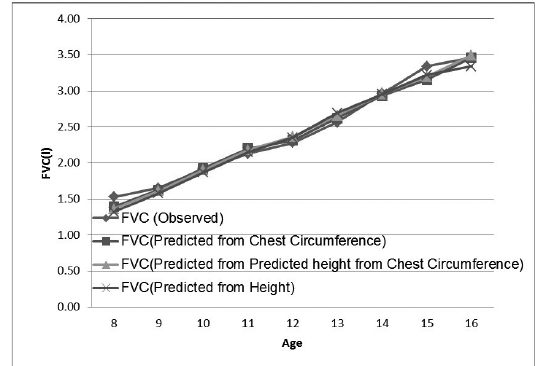
Figure 1a . Comparison of observed/measured FVC values vs predicted values from eqautions based CC (P = 0.38), height derived from CC (P = 0.21) and height (P = 0.83).